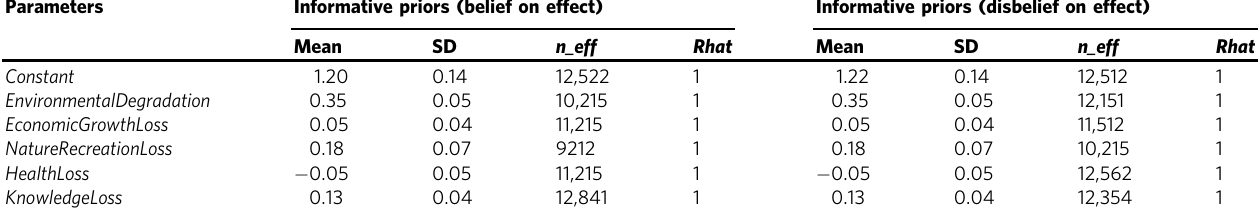
Table 2 Model 1 ’ s simulated posterior results. Parameters